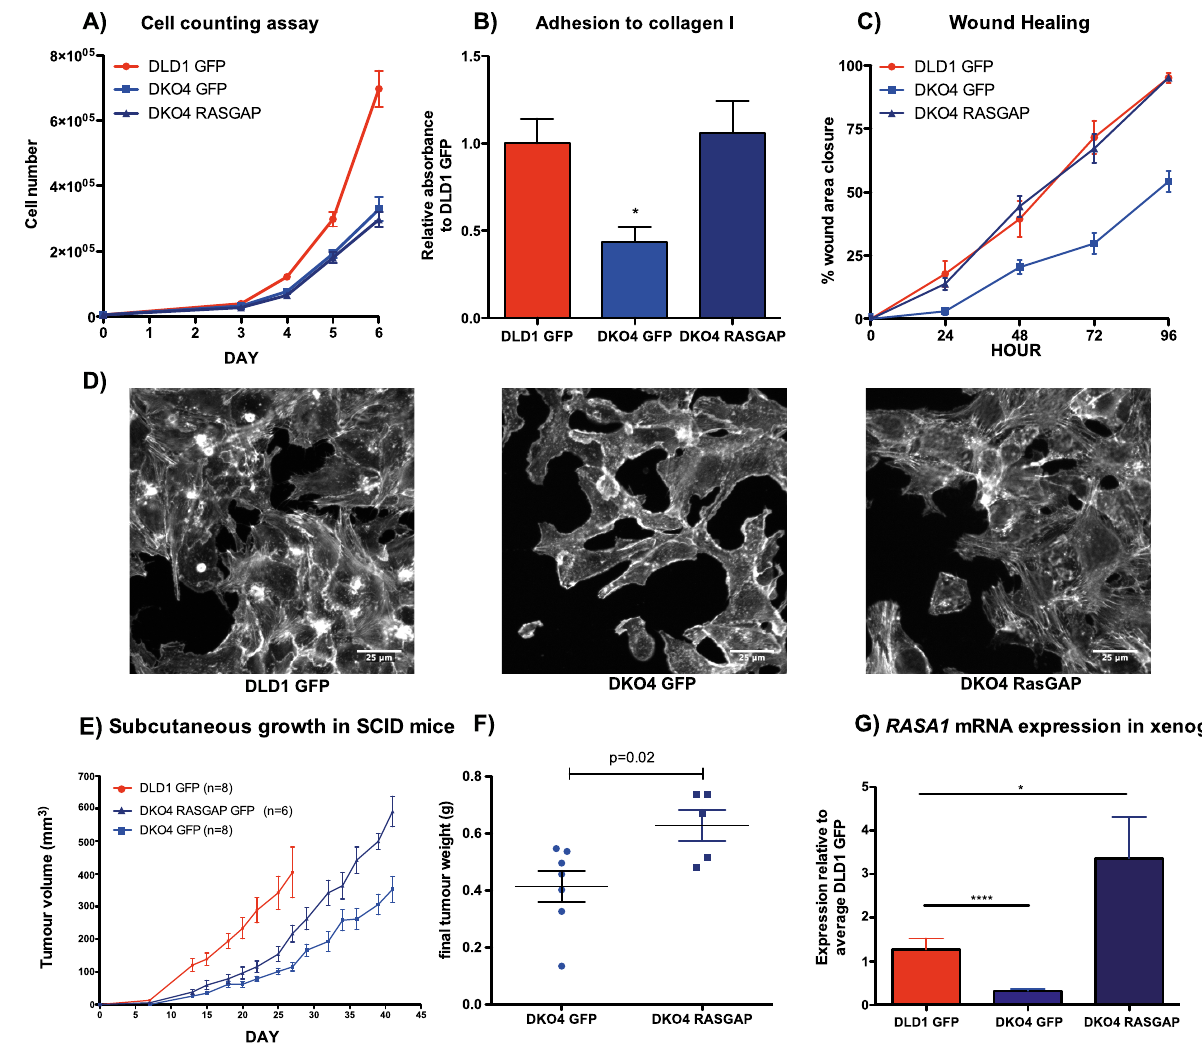
Figure 5. RasGAP overexpression modulates cell adhesion, cell motility, stress fiber formation and tumorigenicity. A) Cell counting assay in RasGAP overexpressing and knockdown cells. B) Cell adhesion to collagen. Statistical significance was determined by t-test: *p , 0.05, ***p , 0.001 C) Wound healing assay. D) Rhodamine-phalloidin staining of actin filaments after overnight adhesion to collagen. E) Tumor volume and (F) final excised tumor weight of xenograft tumors in SCID mice derived from subcutaneous injection of DLD1 empty vector (GFP), DKO4 GFP, or DKO4 overexpressing RasGAP. Number of mice used is indicated on graph. p-value calculated as indicated in materials and methods section. G) rt- qPCR analysis of RASA1 gene expression derived from xenograft tumors after excision.